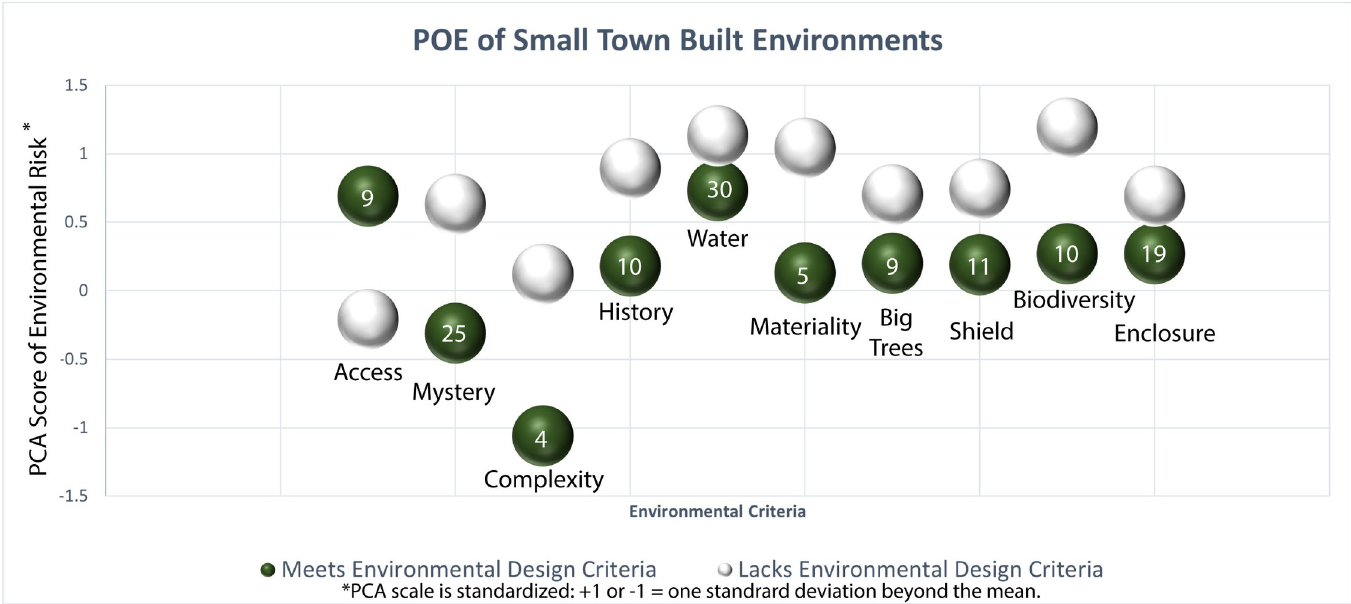
Fig 4. Coefficients from a series of multilevel models identify built environment criteria differentiated as lacking environmental design criteria also being associated with our PCA scale of increase in levels of environmental risk—standardized so that a score of 1 us one standard deviation above the mean—and higher quality environments with lower levels of environmental risk. See Appendix 6 in S1 File for a matrix of exploratory Global Moran I’s post-hoc clusters analyzed in GeoDA 1.18.0. Locations consistently cluster from high quality and low risk to low quality and higher environmental risk. Note that environmental design measures should not be compared in terms of lacking or possessing environmental design criteria—one location may or may not possess multiple criteria—, instead this indicates how specific criteria, like biodiversity, related to environmental risk nested within each location. The number inside each dark green circle indicates the frequency of meeting environmental design criteria.